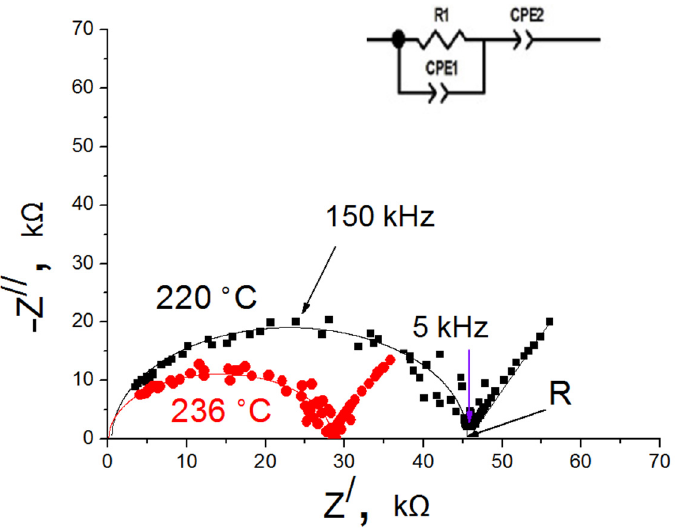
Figure 7. Impedance spectra of 0.3Si glass at 220 °C (black) and 236 °C (red).